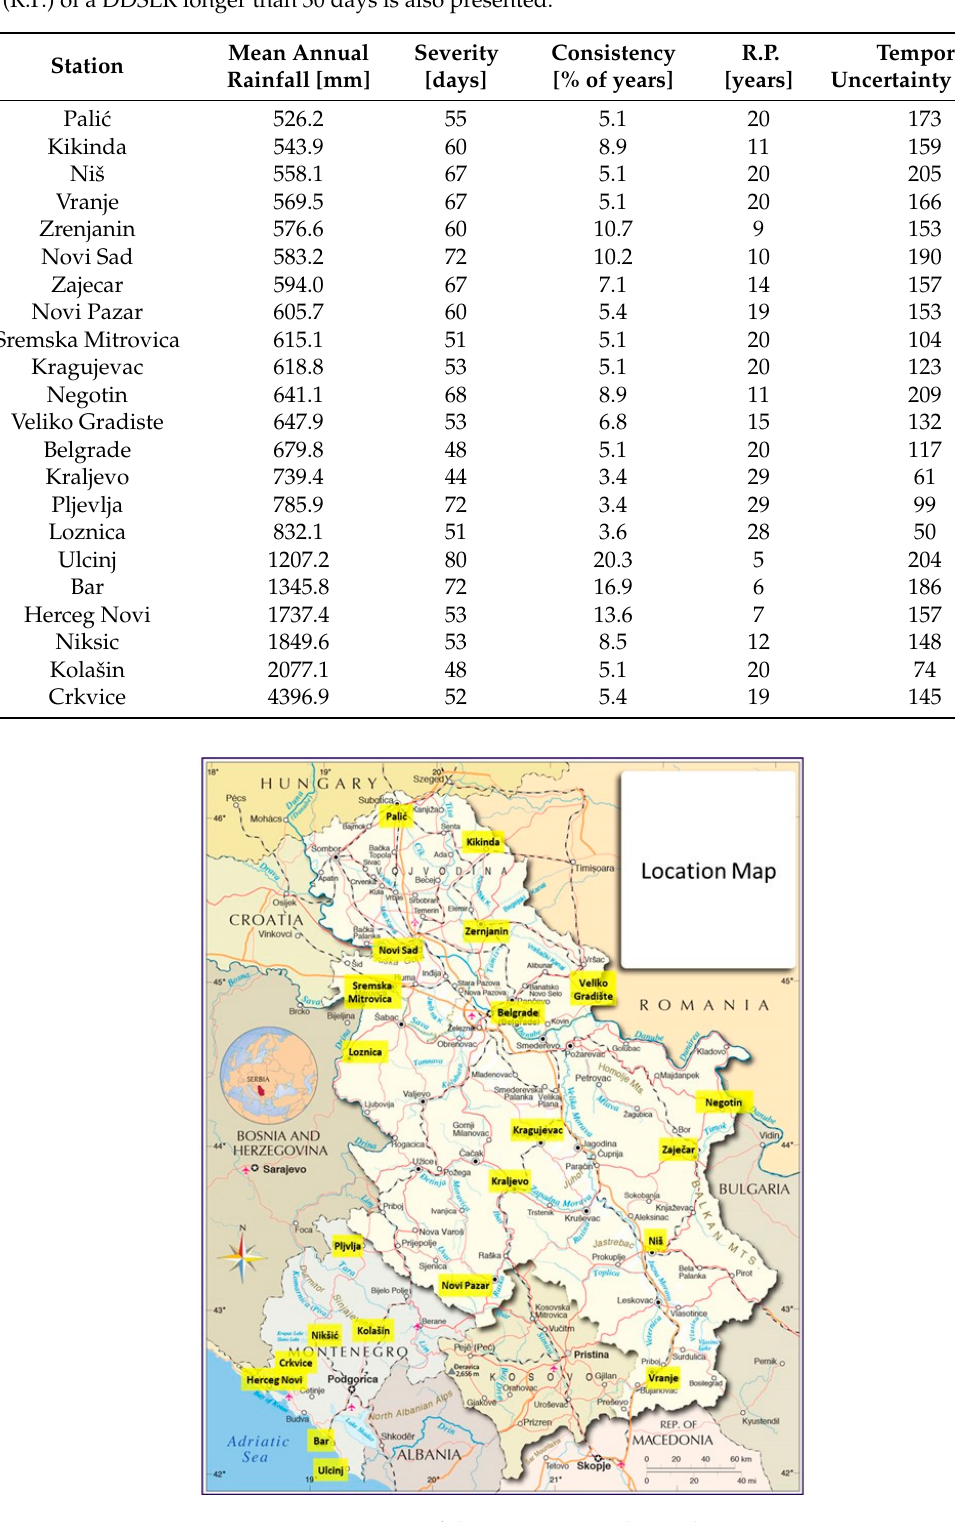
Figure 10. Location map of the stations in Serbia and Montenegro.